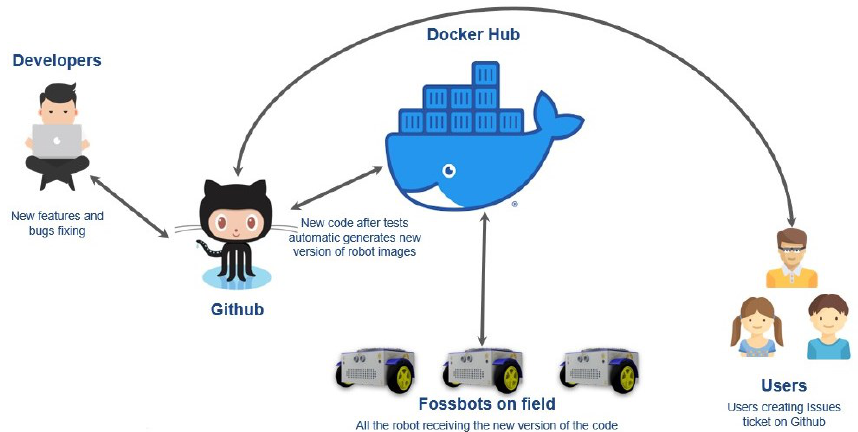
Figure 8. The software stack with the flow between robots, users and